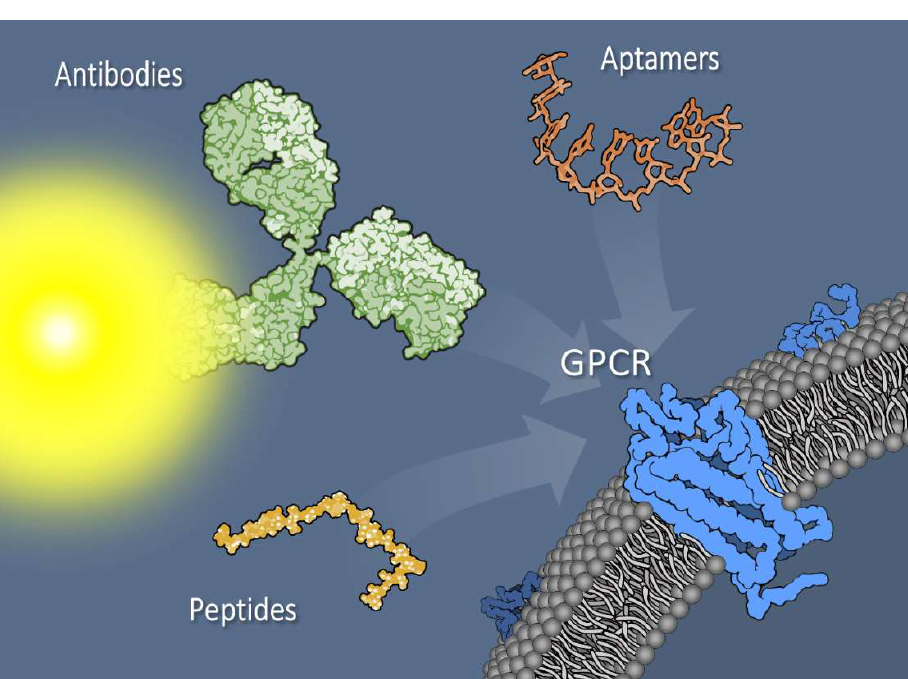
Figure 1. Pancreatic tumor cell surface membrane with G protein–coupled receptors (GPCRs) can be targeted with a variety of reagents, including antibodies (depicted as dye-conjugated) or antibody fragments, aptamers, or small peptides. Additionally, novel bi- or multivalent combinations of targeting agents exhibit promise as tools for imaging and treatment. Targeting agents are not drawn to scale.